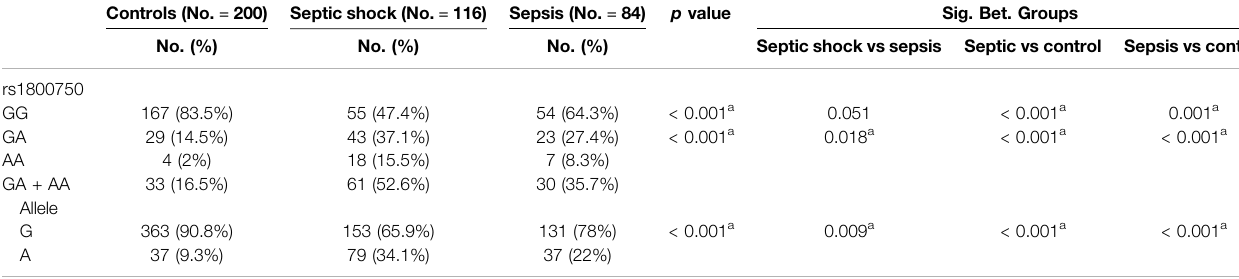
TABLE 2 | Distribution of for TNF- α gene (rs1800750) genotypes among patient groups and controls. Controls (No. = 200) Septic shock (No. = 116) Sepsis (No. = 84)